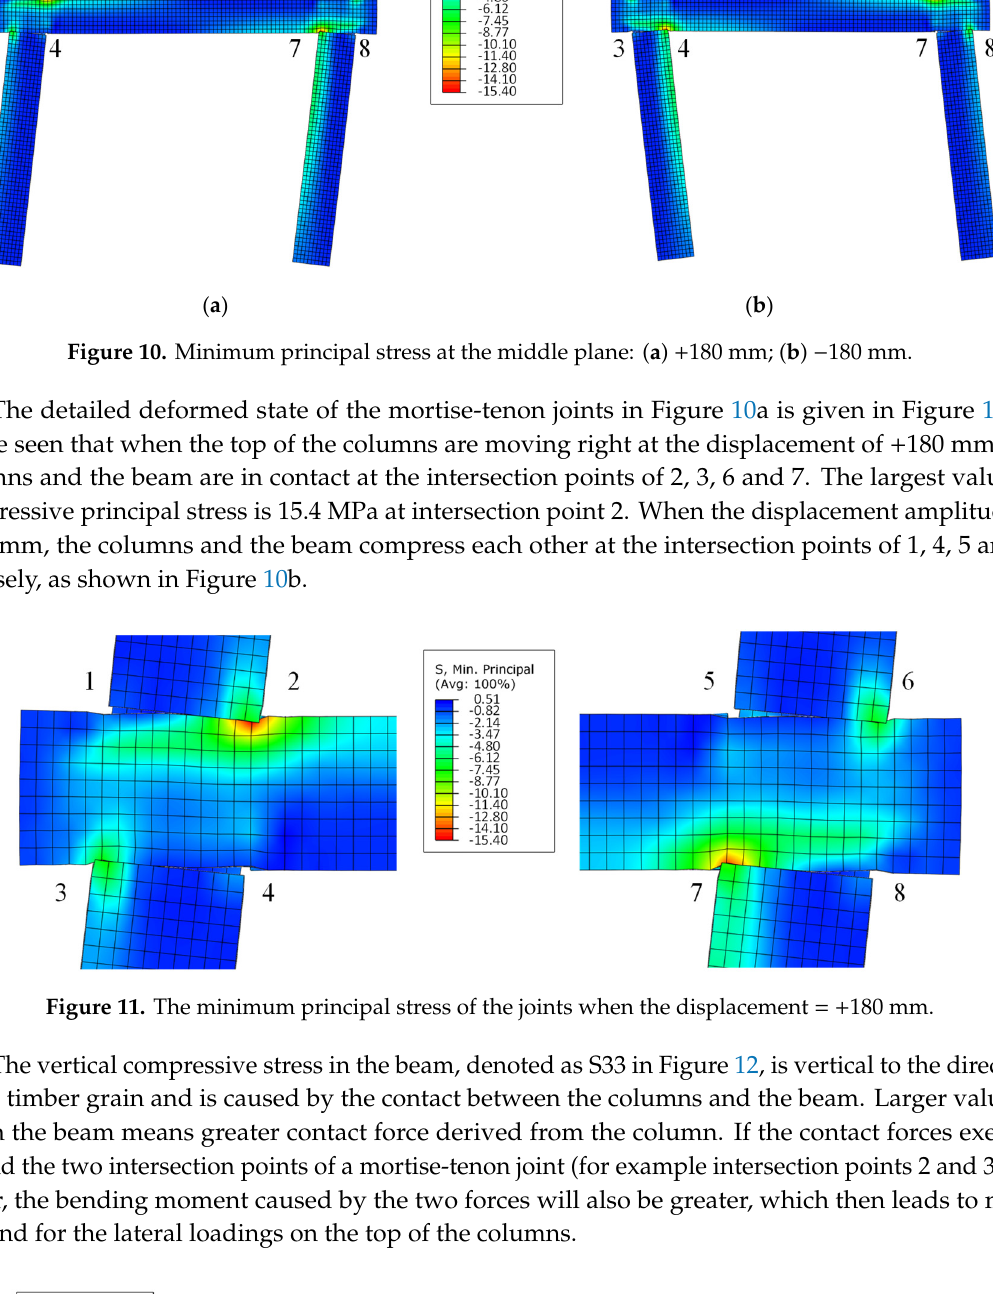
( b ) Figure 9. Results from the experiment and the simulation: ( a ) Stiffness; ( b ) dissipated energy. 3. Stress Analysis